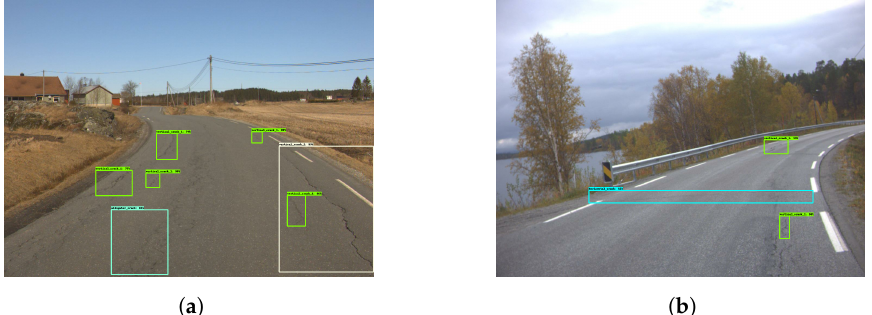
Figure 13. Low sensitivity in damage detection—Model 3. The green and yellow boxes represent the vertical cracks while cyan colored boxes are the horizontal cracks.